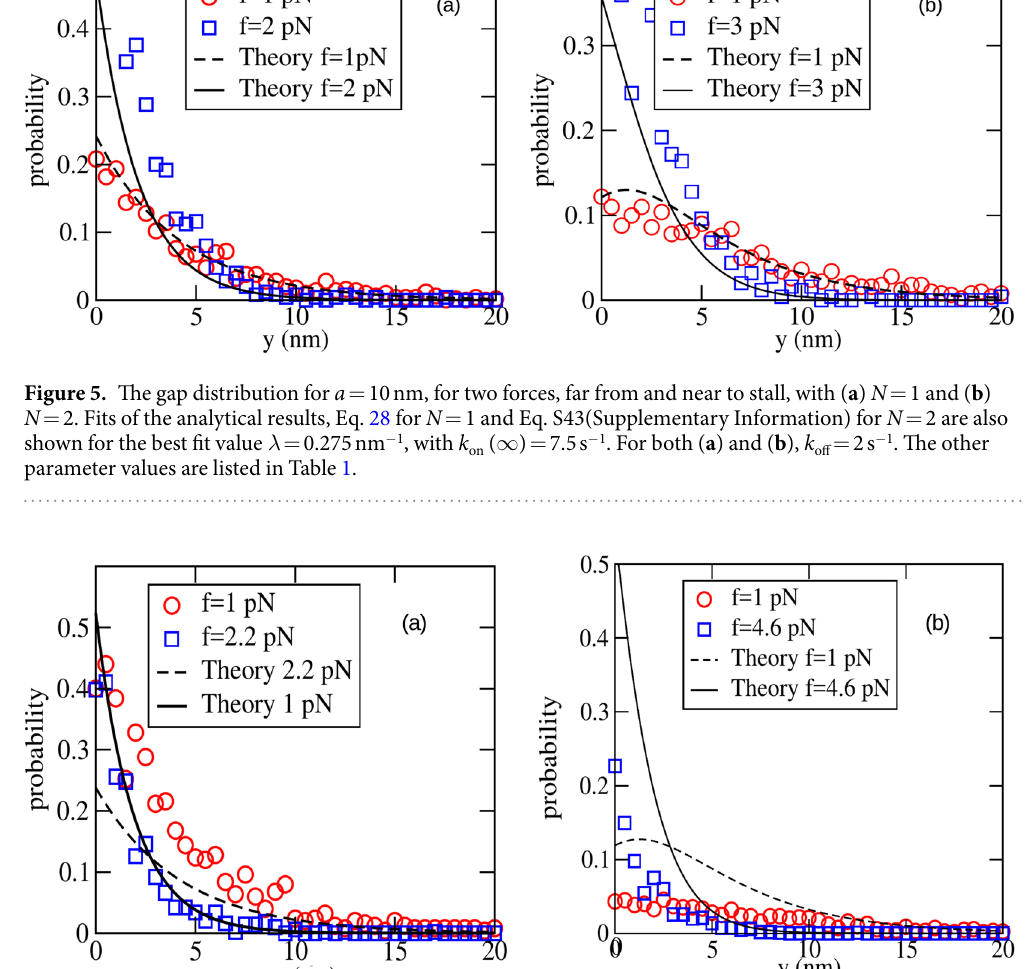
( N = 1) and Eq. S43 in the Supplementary Information ( N = 2). The results are given in Fig. 5 ( a = 10 nm) and Fig. 6 ( a = 2 nm). Quantitative agreement is better for a = 10 nm compared to a = 2 nm, as expected. Microtubule-like filaments. Figure 7 shows the force-velocity curve for one ( N = 1) and two ( N = 2) microtubule-like filaments. The observed stall force for a single microtubule is found to be nearly 5.17 pN in simulations for the parameters used here. For comparison, for the same set of parameters, the prediction of the Brownian ratchet model (Eq. 41) for the combined stall force of 13 independent protofilaments is 12.24 pN. Therefore, we again encounter sublinear scaling of stall force, here as a function of the number of (proto)fila- ments, similar to the experimental observations in 21 . This can be explained using two different, but essentially equivalent arguments: